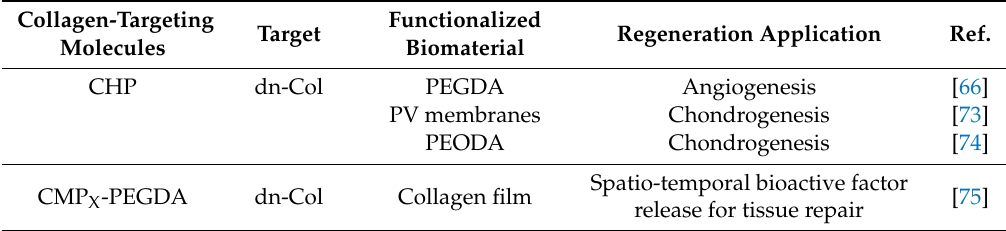
Table 2. Biomaterial functionalization using collagen-targeting molecules for regenerative application.